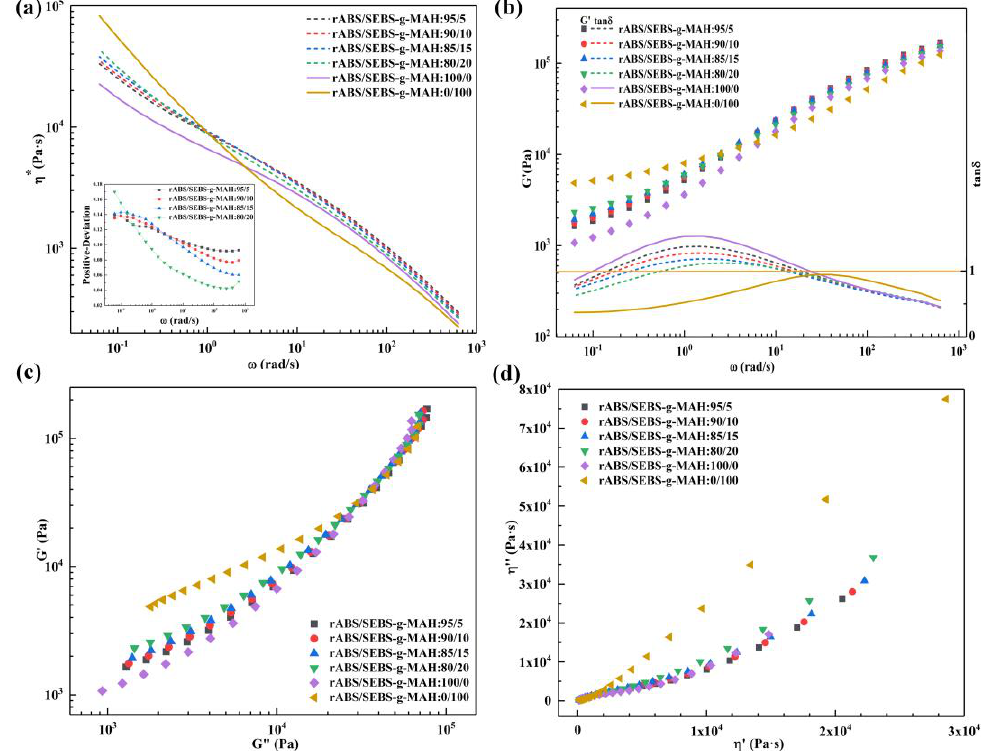
Figure 9. Rheological behavior of the rABS/SEBS-g-MAH blends at 210 °C: ( a ) Frequency dependence of η * and the positive deviation vs. ω ; ( b ) Frequency dependence of G’ and tan δ ; ( c ) the Han curves; and, ( d ) the Cole–Cole curves.